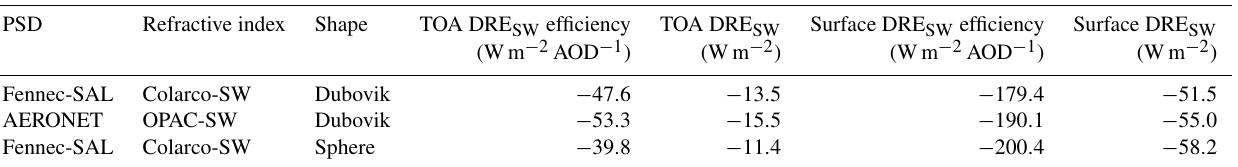
Table 2. Instantaneous DRE SW and DRE SW efficiency at TOA and the surface based on different dust models (e.g., PSD, refractive index, and shape).